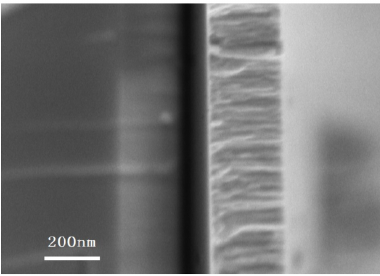
Figure 4. Cross-sectional image of thin film a deposited at 25 ◦ C for 60 min with 65 W.